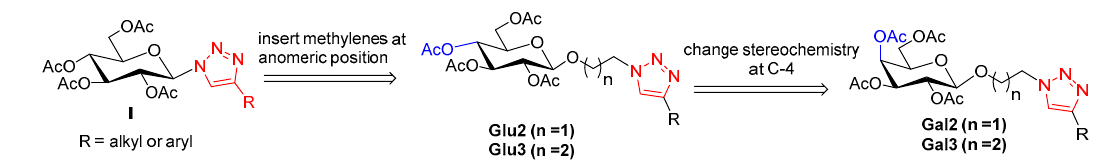
Figure 1. Structures of the glycosyl-triazole conjugates designed from the triazole derivatives with two ( Glu2 and Gal2 ) and three ( Glu3 and Gal3 ) carbon